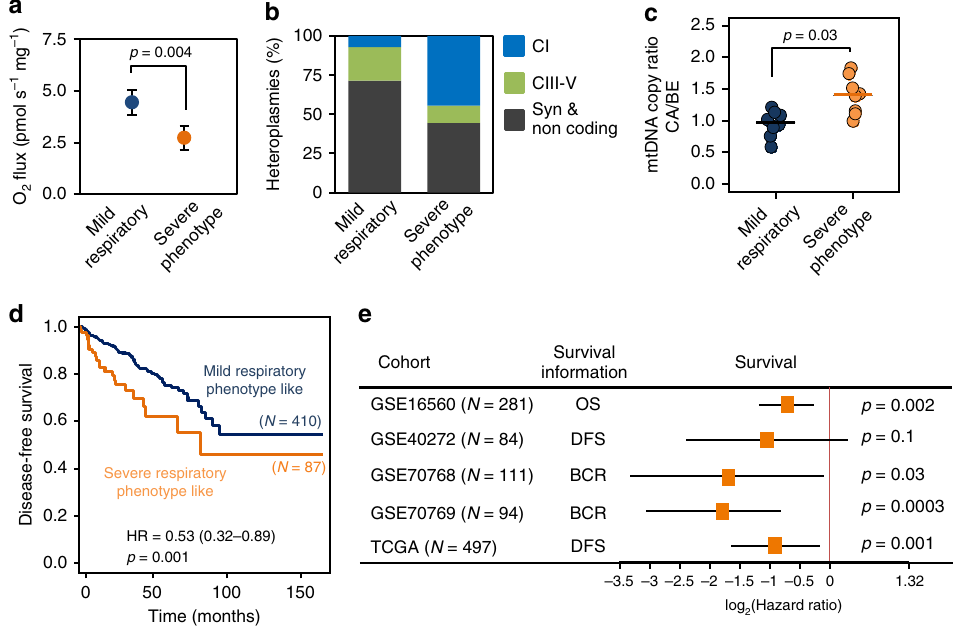
Fig. 8 Association of severe respiratory phenotype and survival. a Glutamate&malate-linked OXPHOS capacity (GM P ) in the severe (orange) versus mild (blue) respiratory phenotype PCa tissue samples. Data are presented as mean values ± SD. Differences were tested for signi fi cance using Wilcoxon rank- sum test. b Relative proportion of synonymous (gray), non-synonymous CIII-IV (green) and non-synonymous CI (blue) mtDNA mutations detected in samples of the mild and severe respiratory phenotype tumors, respectively. c mt-CN ratios (CA/BE) as determined by duplex qPCR in the severe (orange, N = 8) versus mild (blue, N = 8) respiratory phenotype PCa samples. Mean and individual data points are presented and differences were tested for signi fi cance using Wilcoxon rank-sum test. d – e Gene expression pro fi les and survival information (OS, overall survival; DFS, disease-free survival; BCR, time to biochemical recurrence) were retrieved for fi ve prostate cancer cohorts. The metagene set of 11 genes (Table 2) highly correlated to the gene